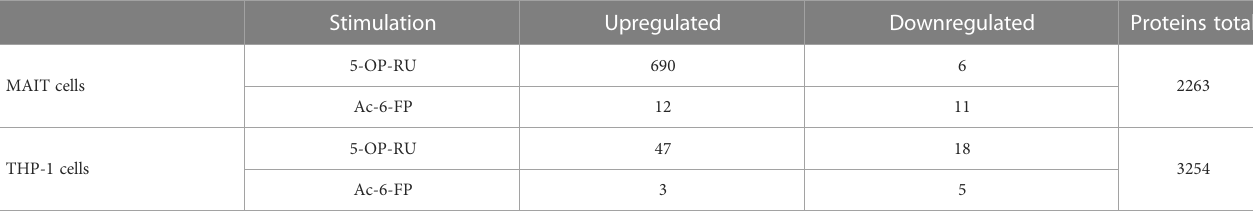
TABLE 2 Regulated protein translations of interacting MAIT and THP-1 cells in the presence of MR1-ligands. Stimulation